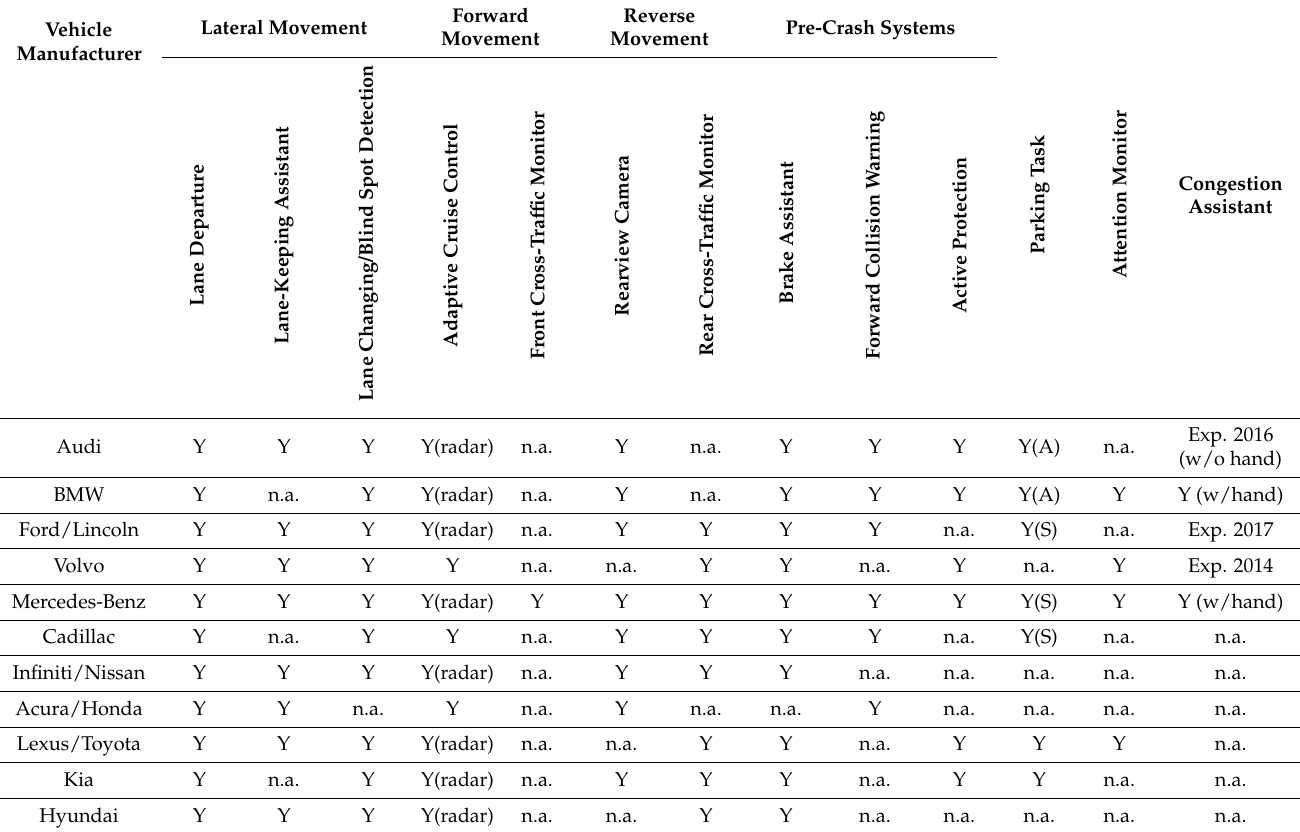
Table 2. Available assistive